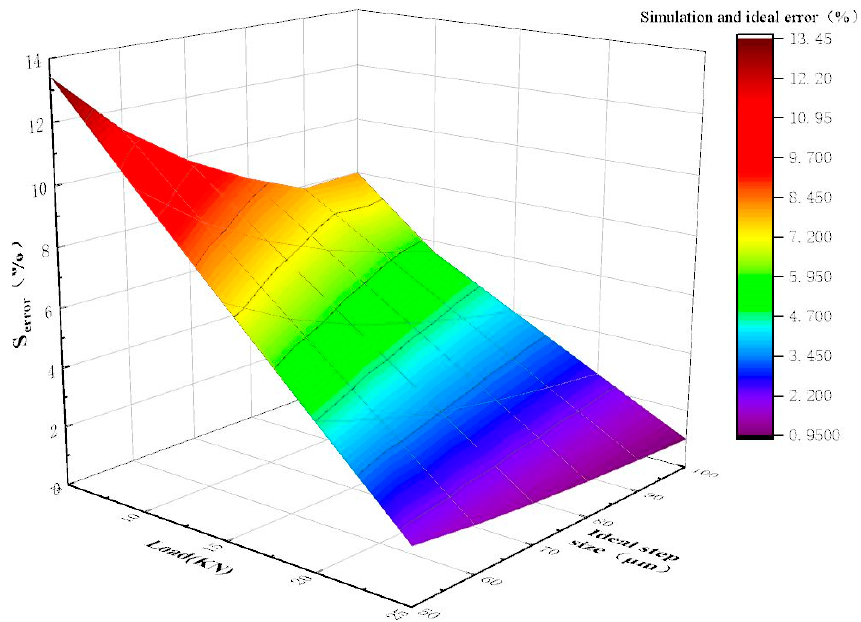
Figure 8. The error between the actual step size and the ideal step size under different working conditions of the original stepper drive.